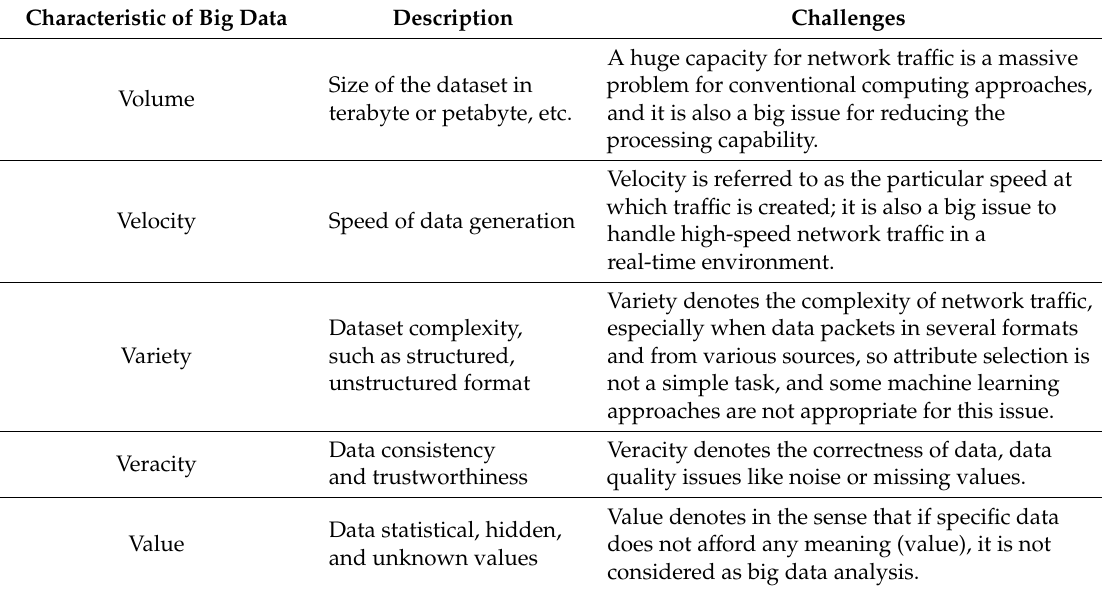
Table 1. Intrusion detection challenges in a big data heterogeneous